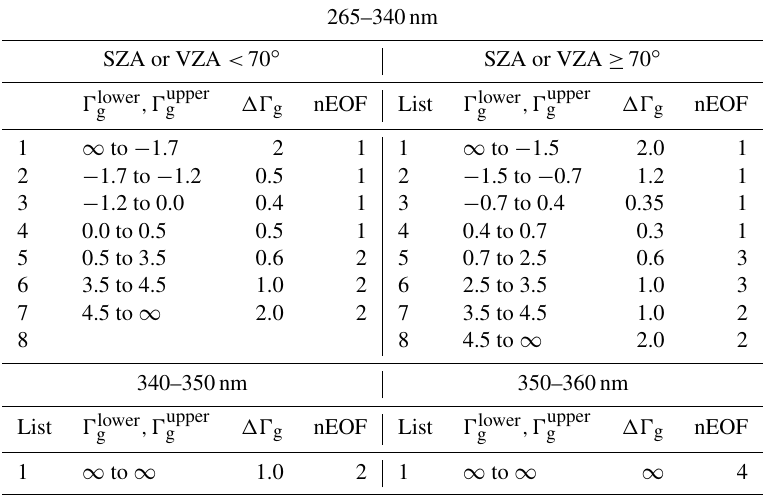
Table 1. The PCA-RT configuration optimized over the UV spectral range 265–360nm. The optical depth of the total gas column ( (cid:48) g defined in Eq. 9) is used to set the criteria for the spectral binning; for example, one or more bins are created at intervals ( (cid:49)(cid:48) g ) in the range (cid:48) lower g to (cid:48) upper g . For each bin, the optical states are expanded in terms of the first few number of EOFs (nEOF).